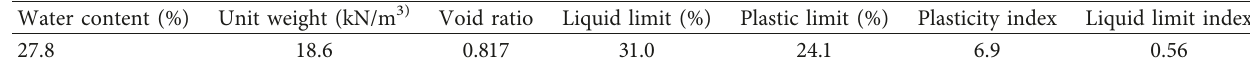
Figure 1: Schematic diagram of tank section of the model (unit: mm). Table 1: Basic physical indexes of